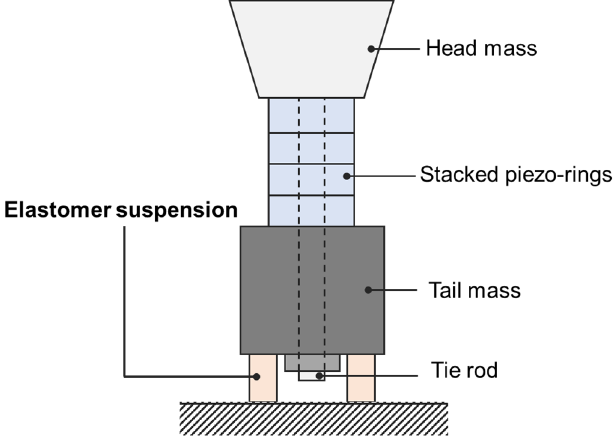
Figure 1. Schematic representation of a rear-mounted Tonpilz projector (4-layer stacked piezo-element as an example). A tail mass is supported by an elastomer suspension to generate a low-frequency resonance below the fundamental longitudinal mode resonance.